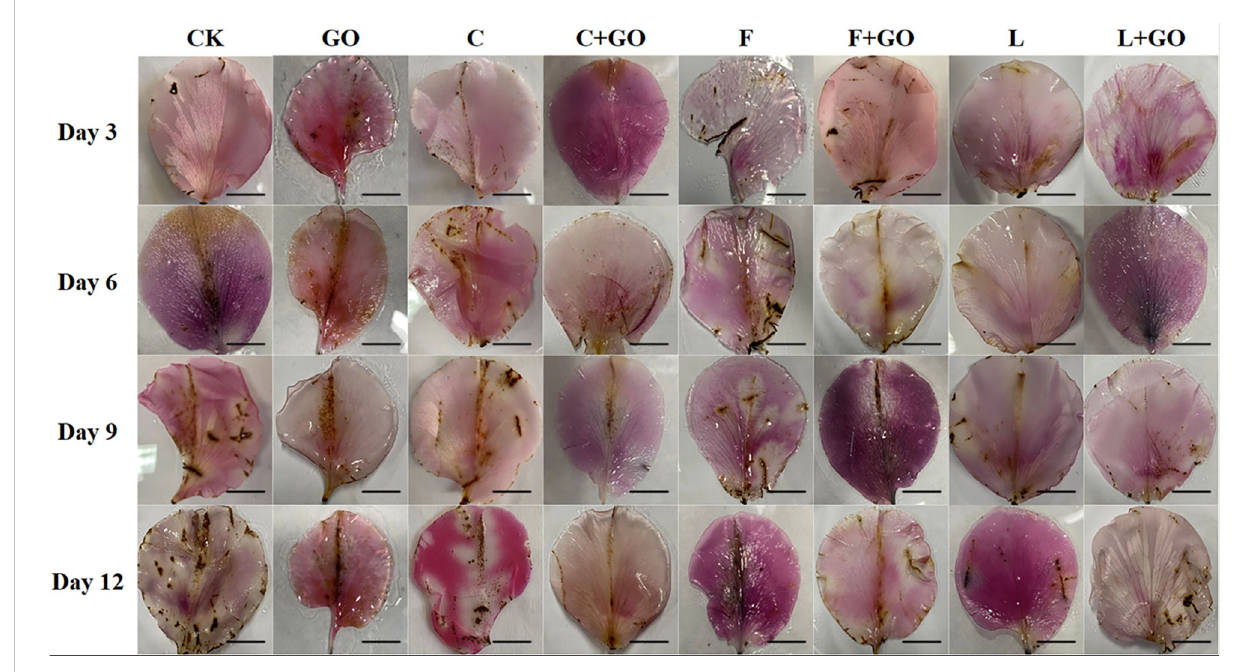
FIGURE 4 DAB staining results of the petals of the cut rose fl owers after 12 d of treatment. Scale bar: 1